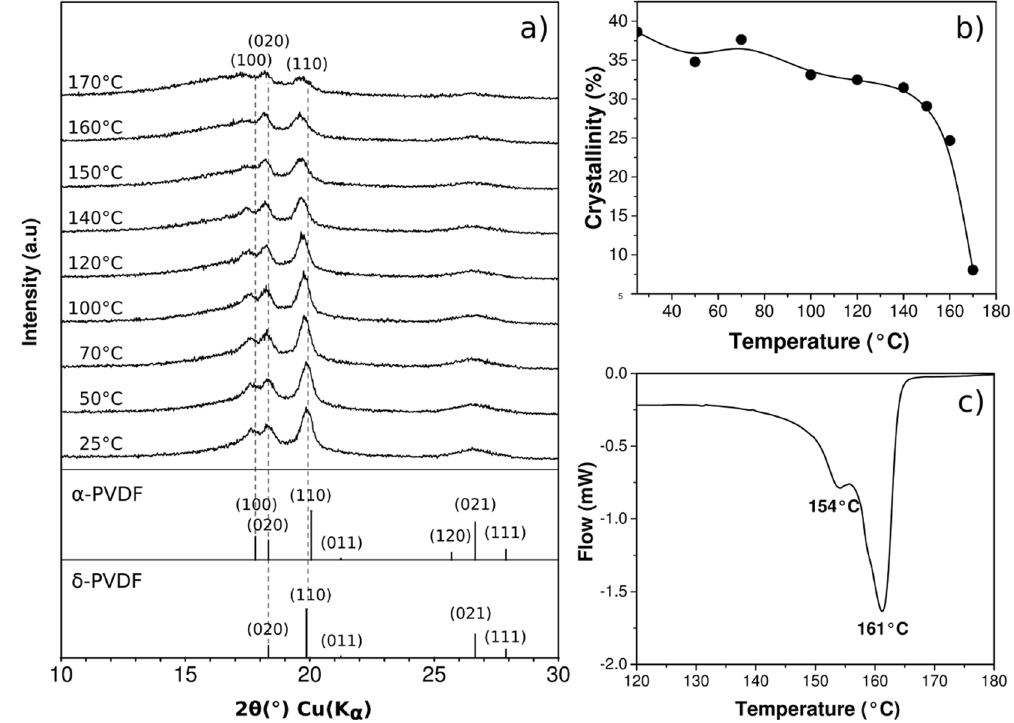
Figure 5. ( a ) GIXRD patterns of PVDF membrane at different temperatures, ( b ) crystallinity vs . temperature plot and ( c ) the differential scanning calorimetry (DSC) curve for the PVDF